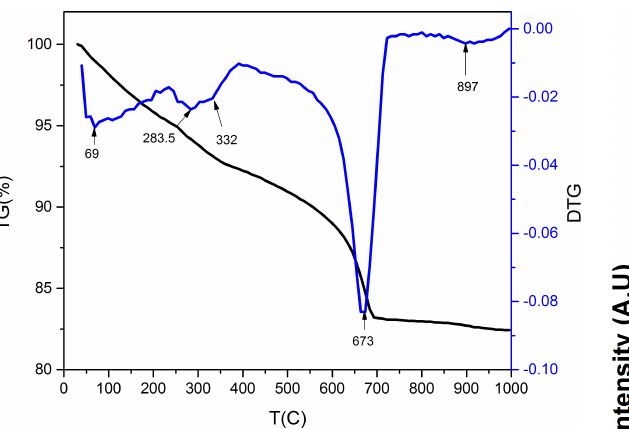
Figure 2: TG and DTG curves of the raw RM sample